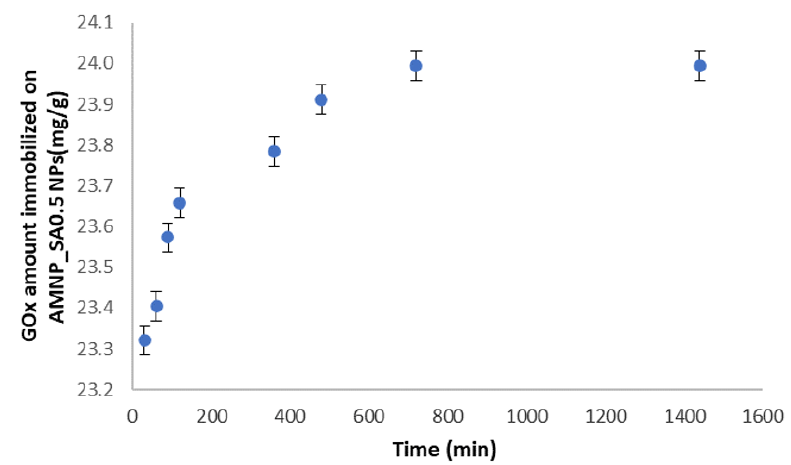
Figure 10. Variation in the amount of enzyme immobilized on AMNP_SA0.5 nanoparticles ’ surface (mg/g MNPs) over time.